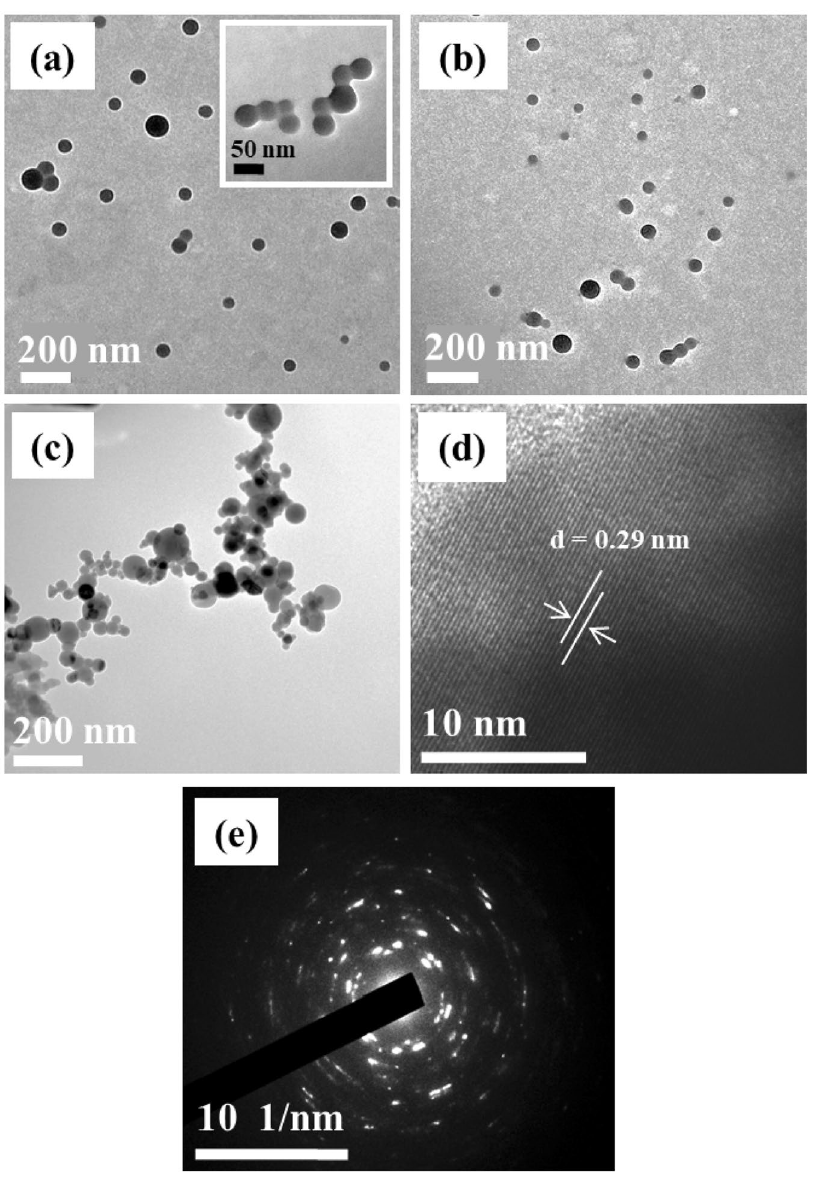
Figure 2. TEM images of NiS nanoparticles synthesized from complex (1) at ( a ) 200 °C, ( b ) 300 °C and ( c ) 400 °C. HRTEM ( d ) and SAED ( e ) images of NiS nanoparticles synthesized from complex (1) at 200